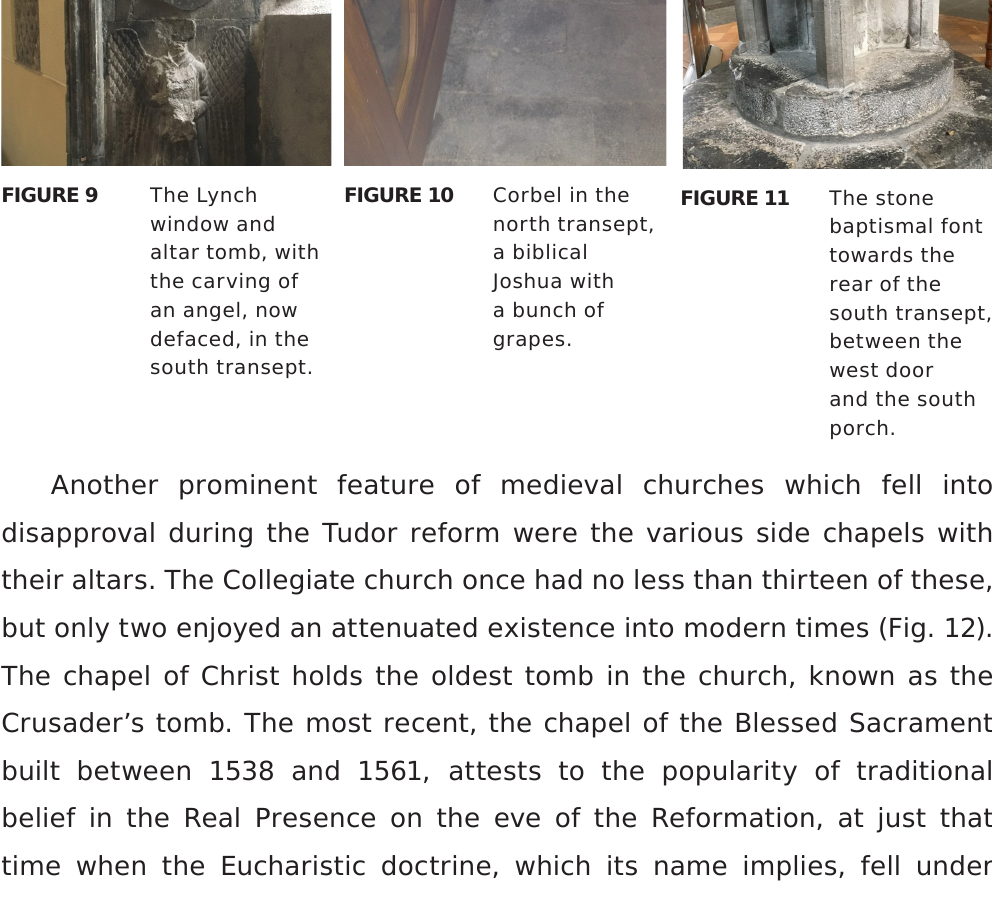
Corbel in the The stone